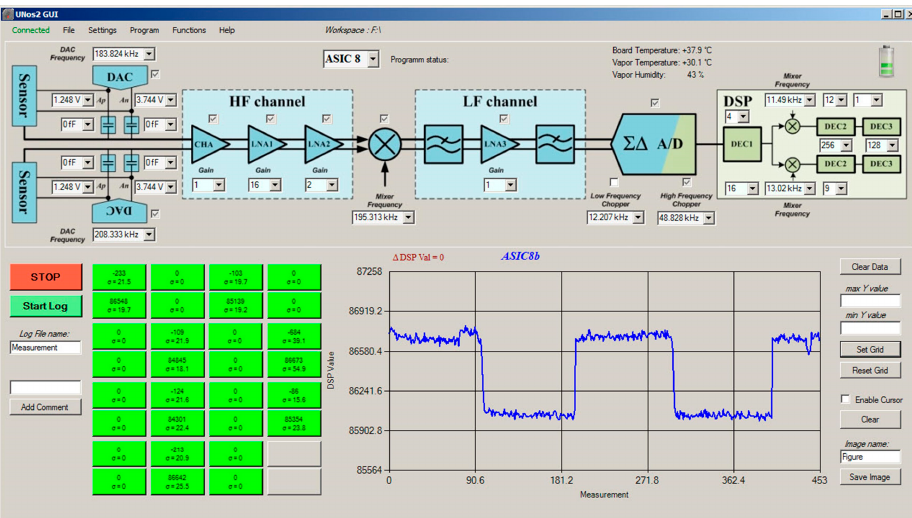
Figure 7. Control screen on the PC, through which it is possible to set the important parameters of the sensors interface, AFE (ASIC) and DSP. A signal from one sensor is presented as a function of time in the lower-right part of the command screen. The responses of all active sensors are presented in real time on the green pixels of the sensor array in the lower left part of the screen. Pixels are differently coloured depending on the real-time value of the signal.